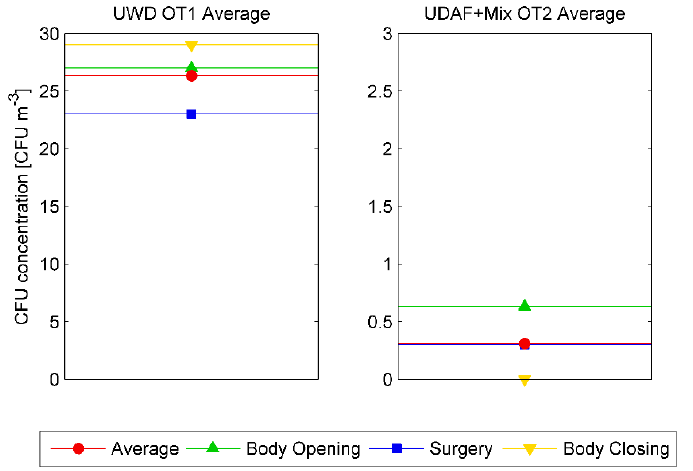
Figure 4. Time average CFU / m 3 values for UWD OT1 (left) and Hybrid OT2 (right) in all surgeries as function of surgery